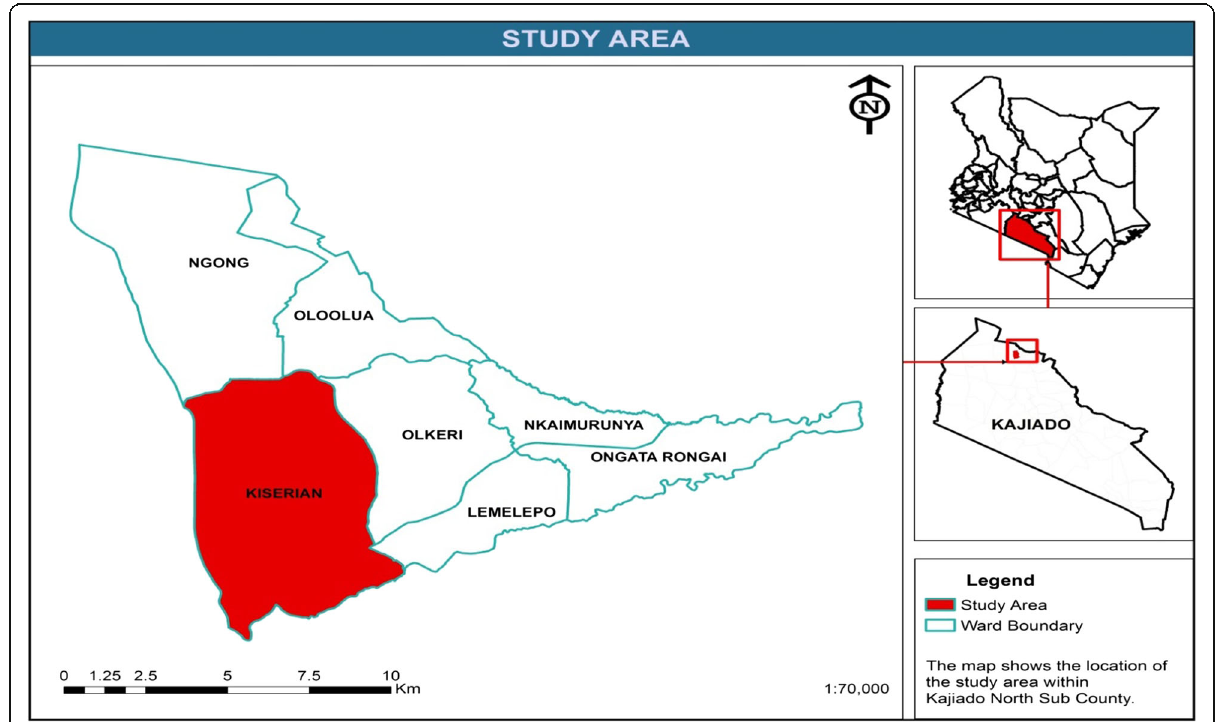
Fig. 1 The study area in Kiserian area, Kajiado County,